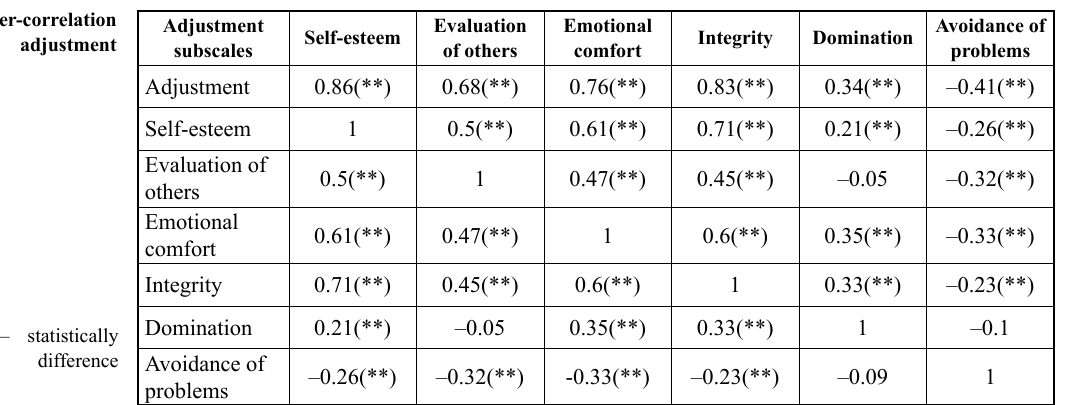
Note. ** – statistically significant difference (p <